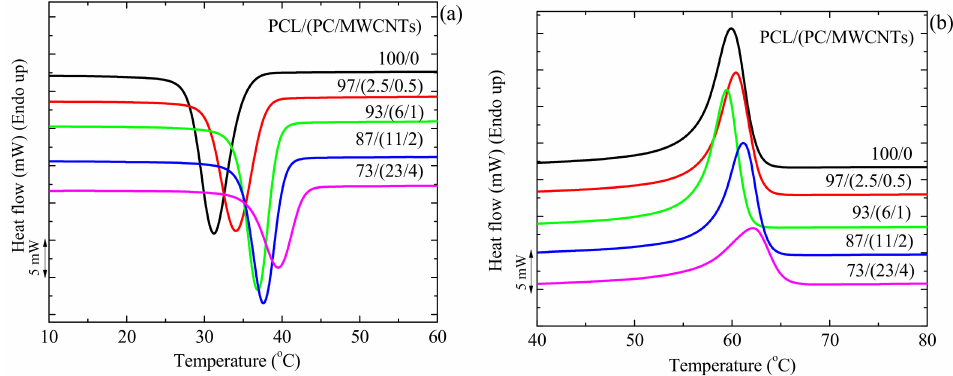
Figure 12. DSC ( a ) cooling and ( b ) second heating curves at 20 ◦ C min − 1 of neat PCL and the PCL/(PC/MWCNT)